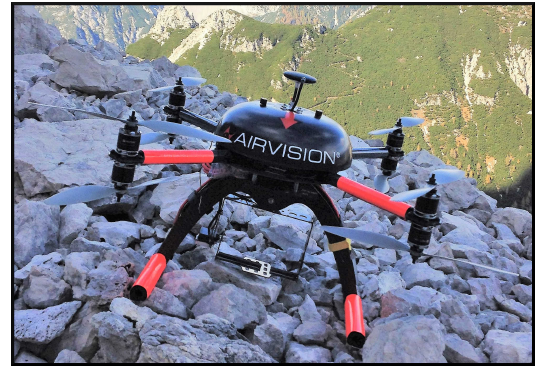
Figure 3. The octorotor UAV used for the surveys.